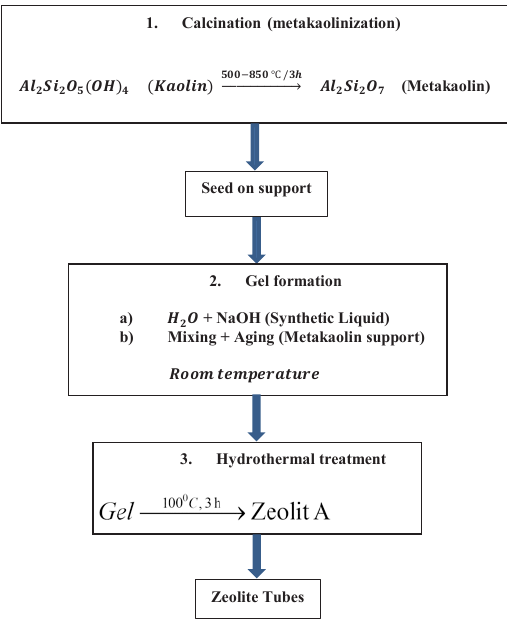
Fig. 2. Flow diagram for the studies parameters in the hydrothermal synthesis of Zeolite A from kaolin.